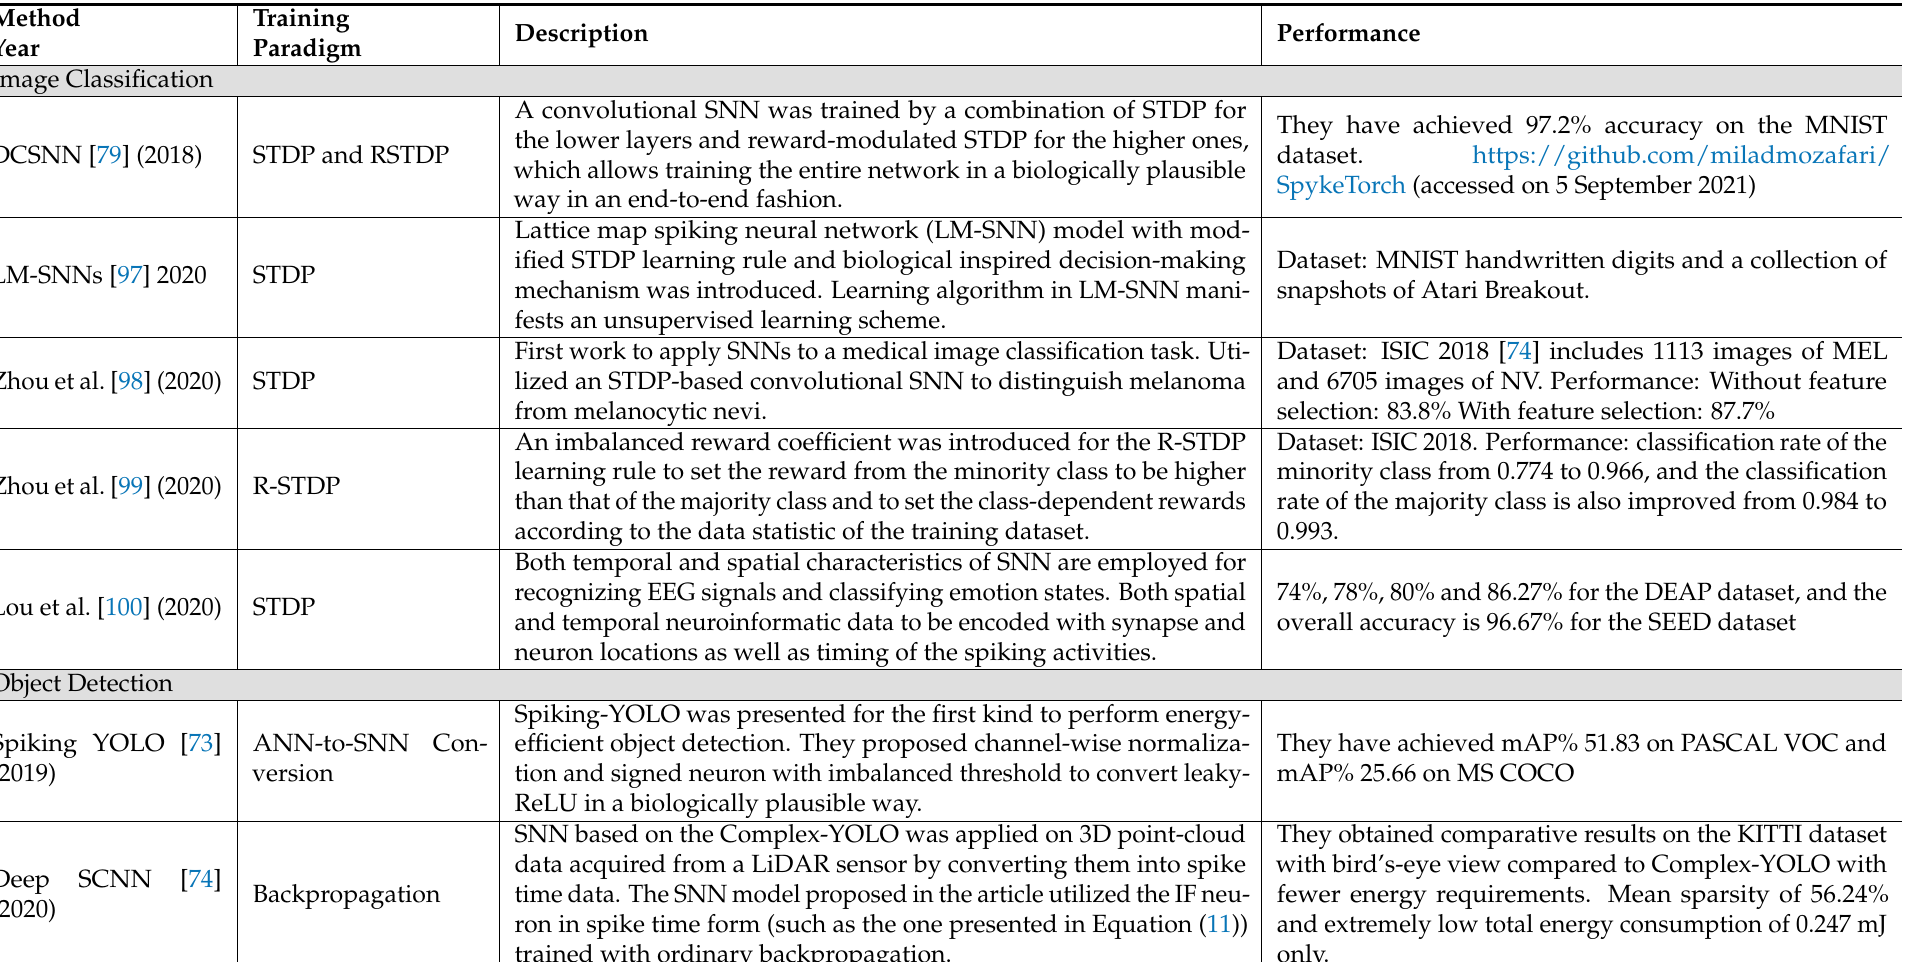
Table 2. Summary of recent applications of SNNs in computer